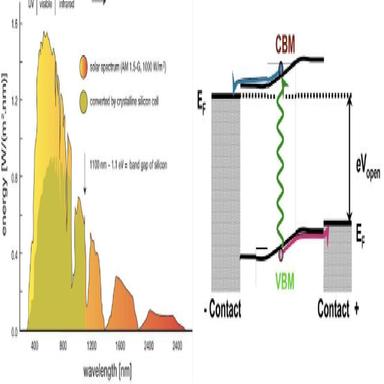
Solar light spectrum (left) and electron-hole pair in semiconductor (right ). Generic energy level diagram of a solar cell, consisting of a light absorber sandwiched between an electron donor and an electron acceptor.